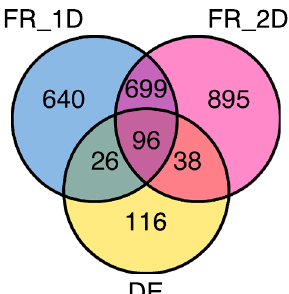
Figure 5. Significant gene overlaps in network curvature and differential expression. Venn diagram of the number of statistically significant genes identified by PPI network Forman-Ricci curvature in the 1D graph model (FR_1D) and 2D complex model (FR_2D) along with classic differential gene expression (DE).